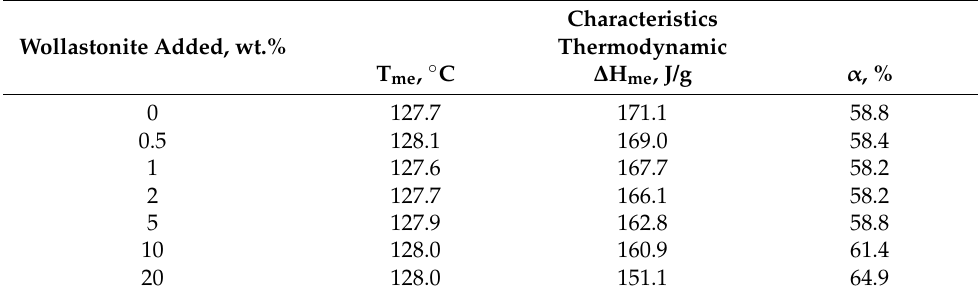
Table 2. Melting point, melting enthalpy, and degree of crystallinity of PCM samples based on UHMWPE and wollastonite.